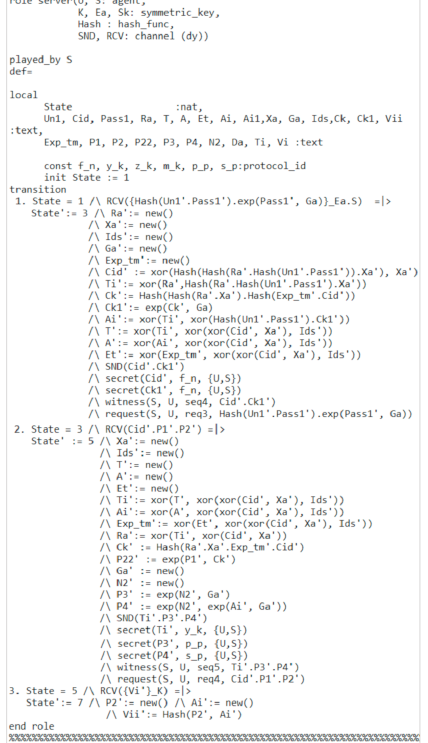
Figure 5. Role specification for